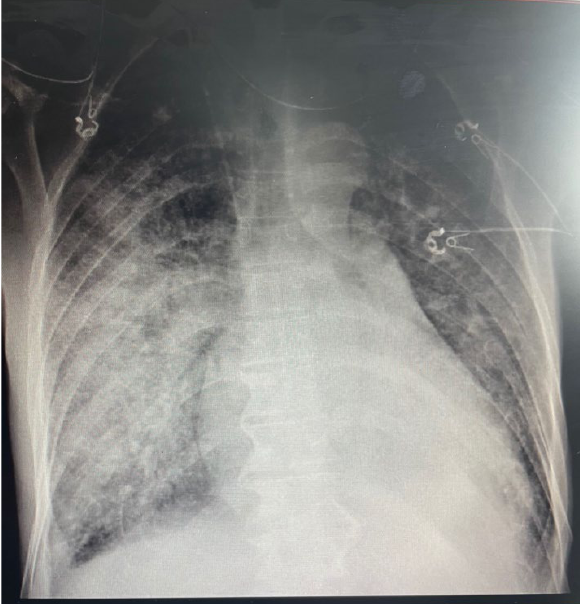
Figure 7. Chest XR at day 6 showing progression of pulmonary lesions suggesting superimposed pulmonary edema.